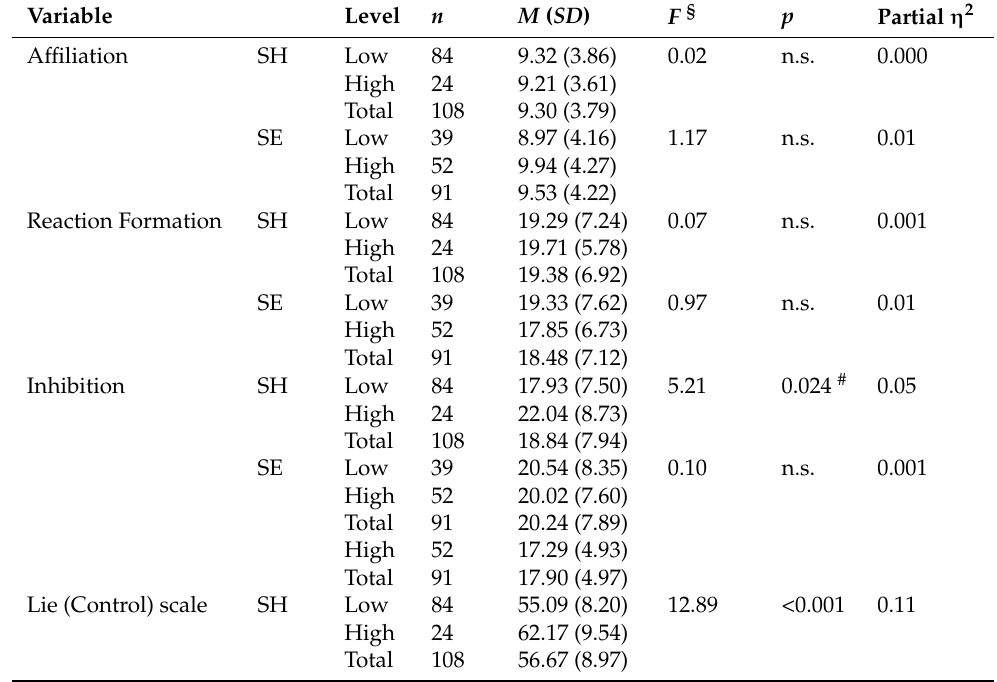
Table 7. Follow-up ANOVAs. DSQ scales by low and high Studyholism (SH) and Study Engagement (SE). Lie scale and other